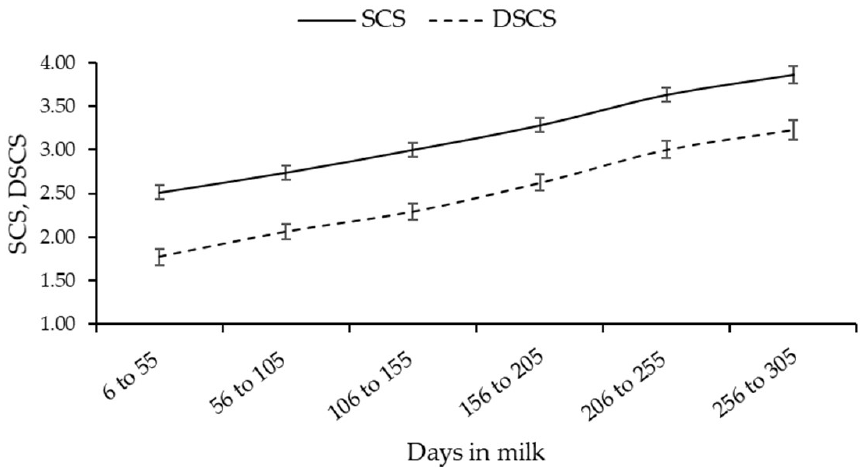
Figure 2. Least squares means of SCS (somatic cell score) and DSCS (log2-transformation of number of polymorphonuclear neutrophils and lymphocytes in milk (cells/mL)) across lactation. The lowest SCS and DSCS were observed in early lactation, whereas the greatest at the end. The two breeds showed different patterns of DSCC ( p < 0.05) throughout DIM (Figure 3), with Alpine Grey having the minimum in early lactation (62.5 ± 1.1%), a peak corresponding with the MY lactation peak (Figure 3; 66.2 ± 1.1%) and a subsequent drop between 106 and 155 DIM followed by a second increase and stabilization. On the